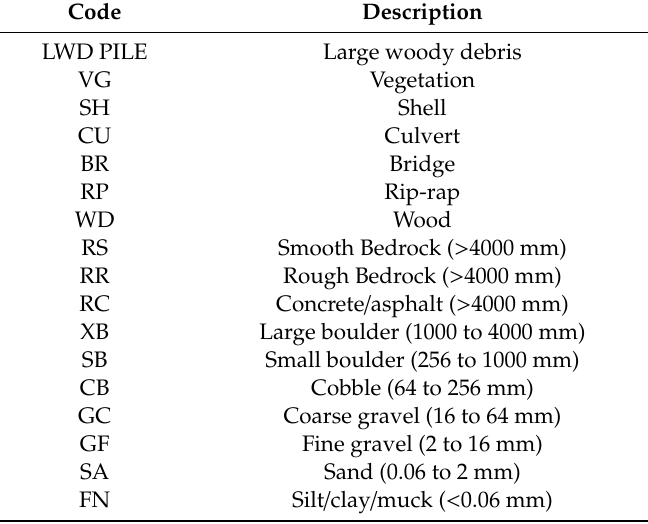
Table 2. Definition of streambed substrate variables used in this